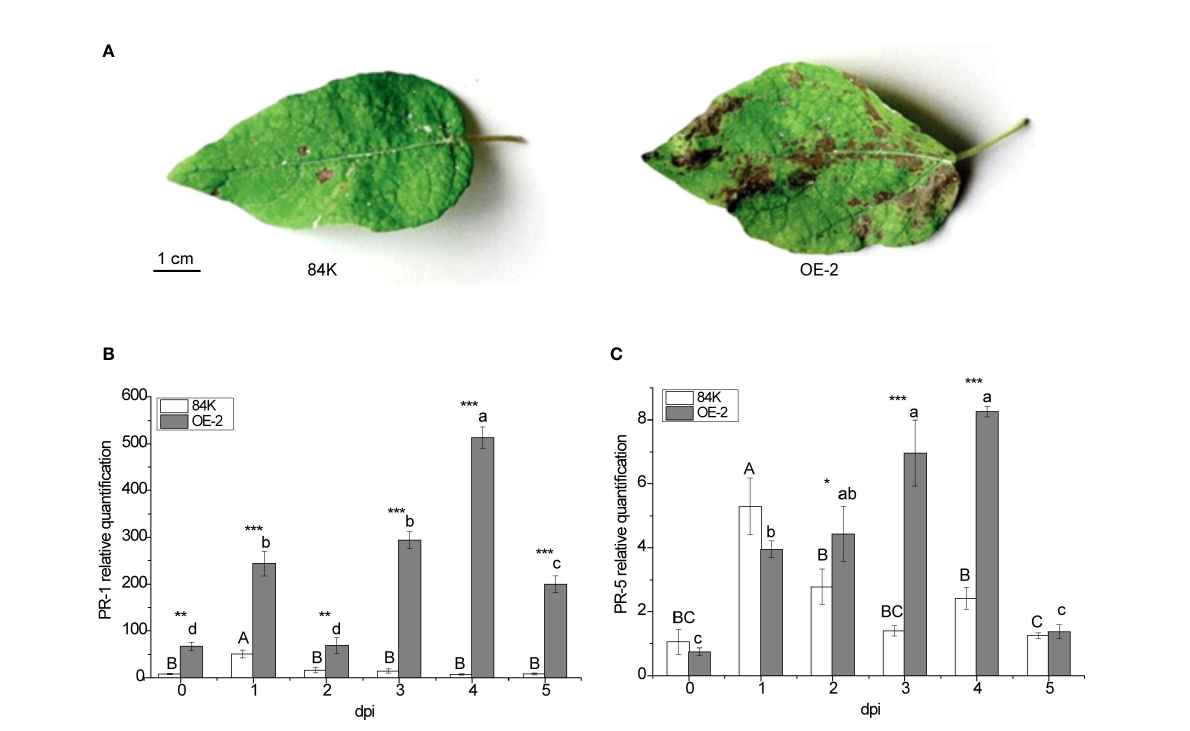
FIGURE 4 Enhanced disease susceptibility of PagSAMT -overexpressing plants to the virulent fungal pathogen B dothidea and disease-related factor responses. (A) Phenotype after inoculation. (B) Expression of PR-1 in infected leaves. (C) Expression of PR-5 in infected leaves. Mean values from three independent plants are given. dpi, days past inoculation. Each bar represents the mean relative expression level of three independent experiments with the standard errors. The bars with asterisks indicate signi fi cant differences between the 84K and OE-2 lines at the same time (* p<0.05 ; ** p<0.01 ; *** p<0.001 ). The uppercase letters are the statistical differences of measured data during the time series of the 84K line, p<0.05 . The lowercase letters are the statistical differences of measured data during the time series of the OE-2 line, p<0.05